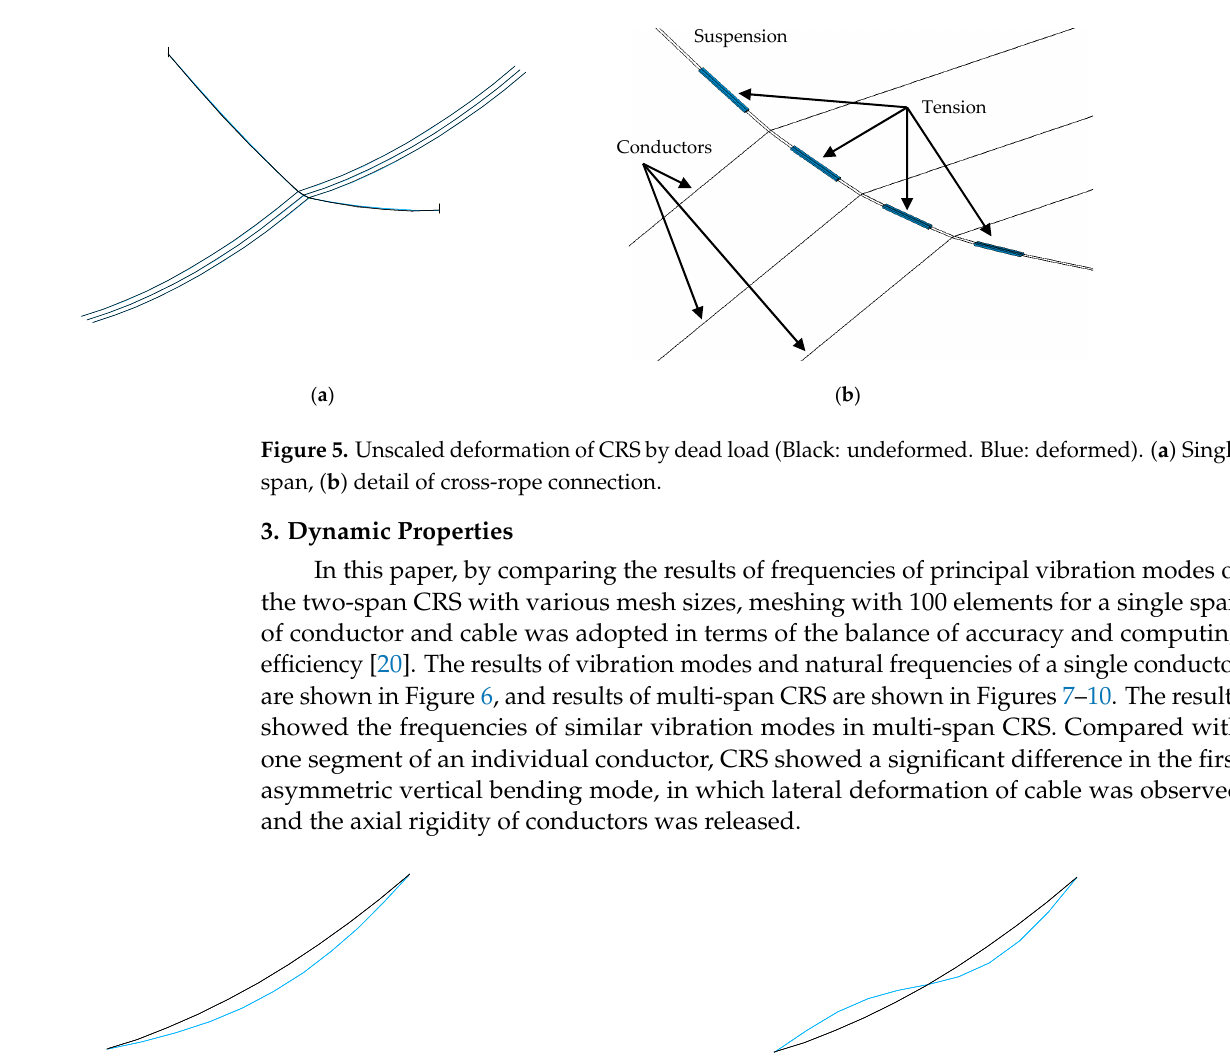
Figure 6. Vibration modes and frequencies of single conductor. ( a ) First symmetric lateral bending (f = 0.080 Hz), ( b ) Second asymmetric vertical bending (f = 0.160 Hz).